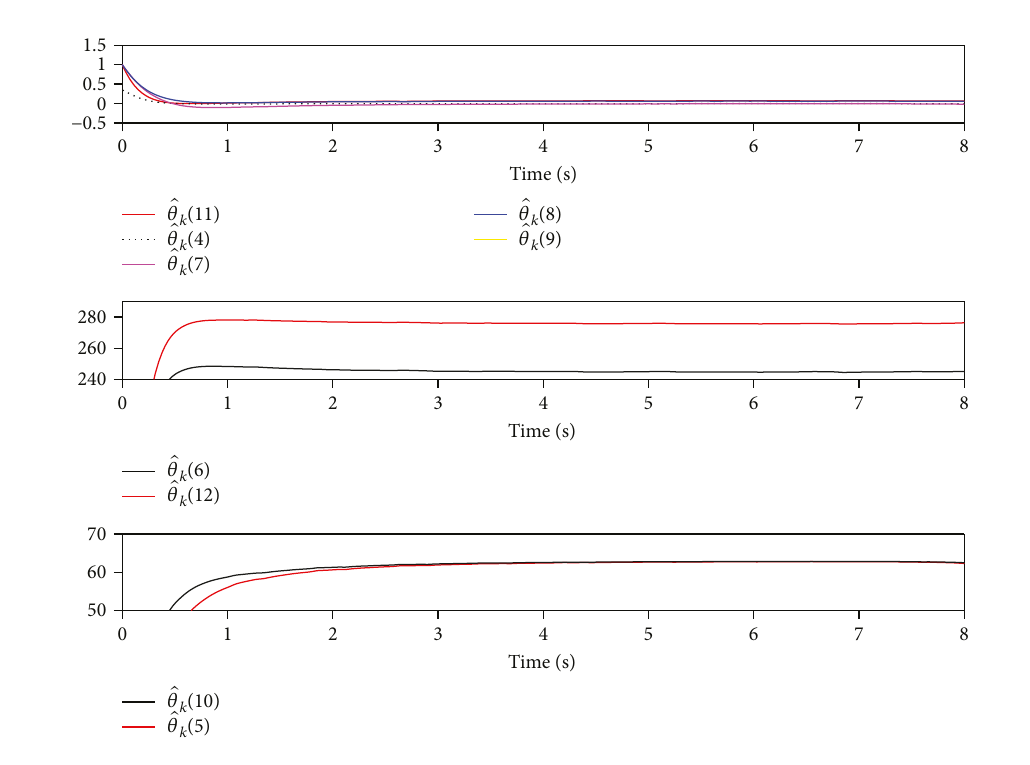
Figure 8: Estimated parameters from θ